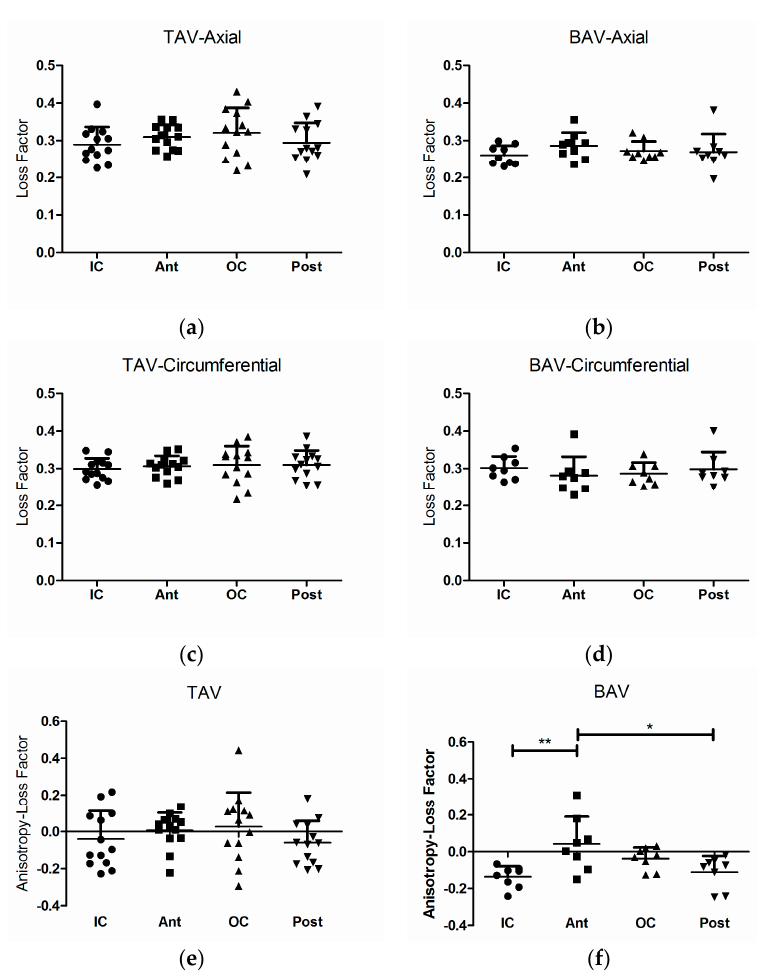
Figure 3. Variation of axial loss factor: ( a ) TAV; and ( b ) BAV groups. Variation of circumferential Loss Factor: ( c ) TAV group; and ( d ) BAV group; Variation of loss factor Anisotropy: ( e ) TAV: No regional effect; ( f ) BAV: significant regional effect ( p = 0.0021) (one-way analysis of variance (ANOVA) with repeated measure and Bonferroni’s multiple comparisons post-test). Asterisks denote significant difference: * p < 0.05 and ** p < 0.01.